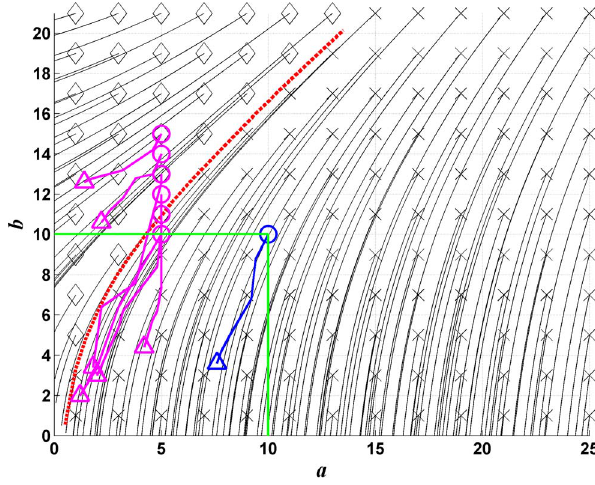
Figure 1. Supremacy phase diagram. Evolution of the trajectories of the deterministic model starting from different initial conditions, projected on the plane determined by the total number of A individuals ( a ) and the total number of B individuals ( b ). Initial conditions indicated by diamonds lead to the supremacy of B ’s ( a ~ 0 ), while the x-marks lead to the supremacy of the species A ( b ~ 0 ). The red dashed line is the separatix between the two phases, where both species die; the green square marks the region where fitting has been performed and where non-linear effects are most effective. The magenta and the blue lines indicate experimental trajectories, each one given by an average over 5 experiments. doi:10.1371/journal.pone.0111310.g001 analysis. The combination A , B , AB , ABB and ABBB are referred to as "chemical species" or "molecules", following the terminology used in chemical modeling [18].